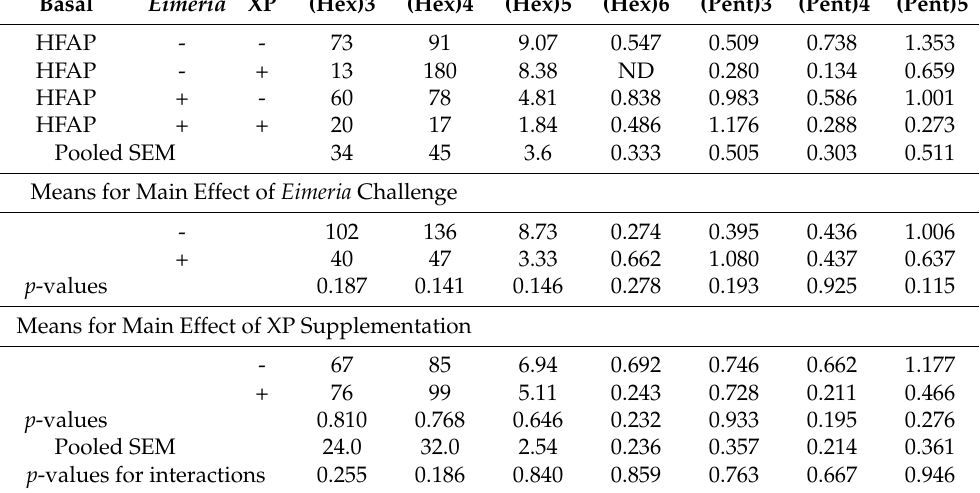
Table 8. Oligosaccharide profile ( µ g/mg) in jejunal digesta of broiler chickens challenged or unchal- lenged with mixed Eimeria spp. in response to feeding diets with high fiber and adequate protein levels with or without enzyme supplementation (Expt. 1). Basal Eimeria XP